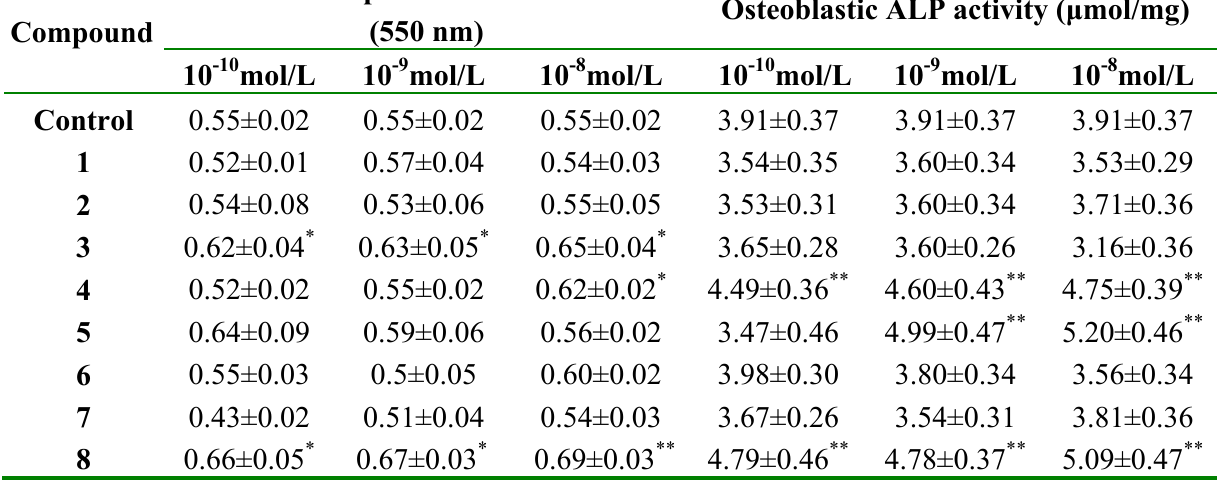
Table 2. Effects of compound 1-8 on osteoblast proliferation and ALP activity in neonatal rat calvaria cultures (n=8, x±SD).